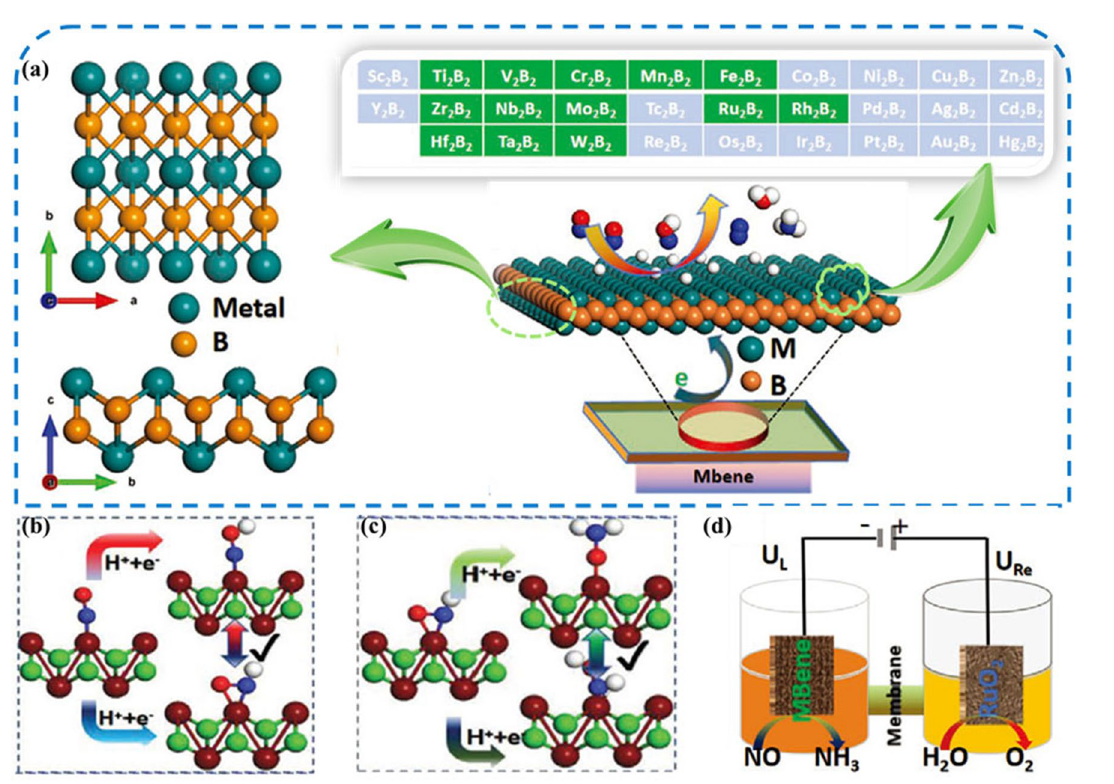
Fig. 13 a Top views of the M 2 B 2 MBene monolayers. The metal and boron atoms are marked by cyan and orange spheres, respectively. Researchers screened M 2 B 2 monolayers, including 3d, 4d, and 5d transition-metal boride compounds. Green and light blue represent stable and unstable M 2 B 2 , respectively, which were verified from phonon spectrum calculations. b, c Schematic illustration of bifurcation reaction steps during the hydrogenation of NO to NH 3 on V 2 B 2 MBenes. d A schematic diagram of the desired electrochemical cell for the NORR (cathode: MBene) and OER (anode: RuO 2 , for reference electrode). Reproduced with permission from Ref. [206]. (Color figure